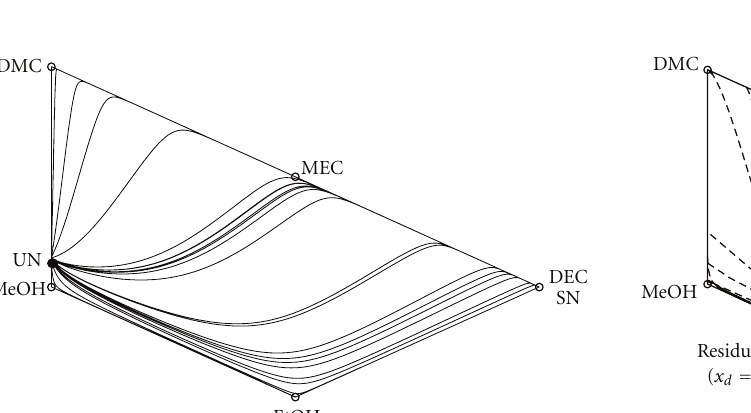
Figure 2: The nonreactive system unfolded in 2D.